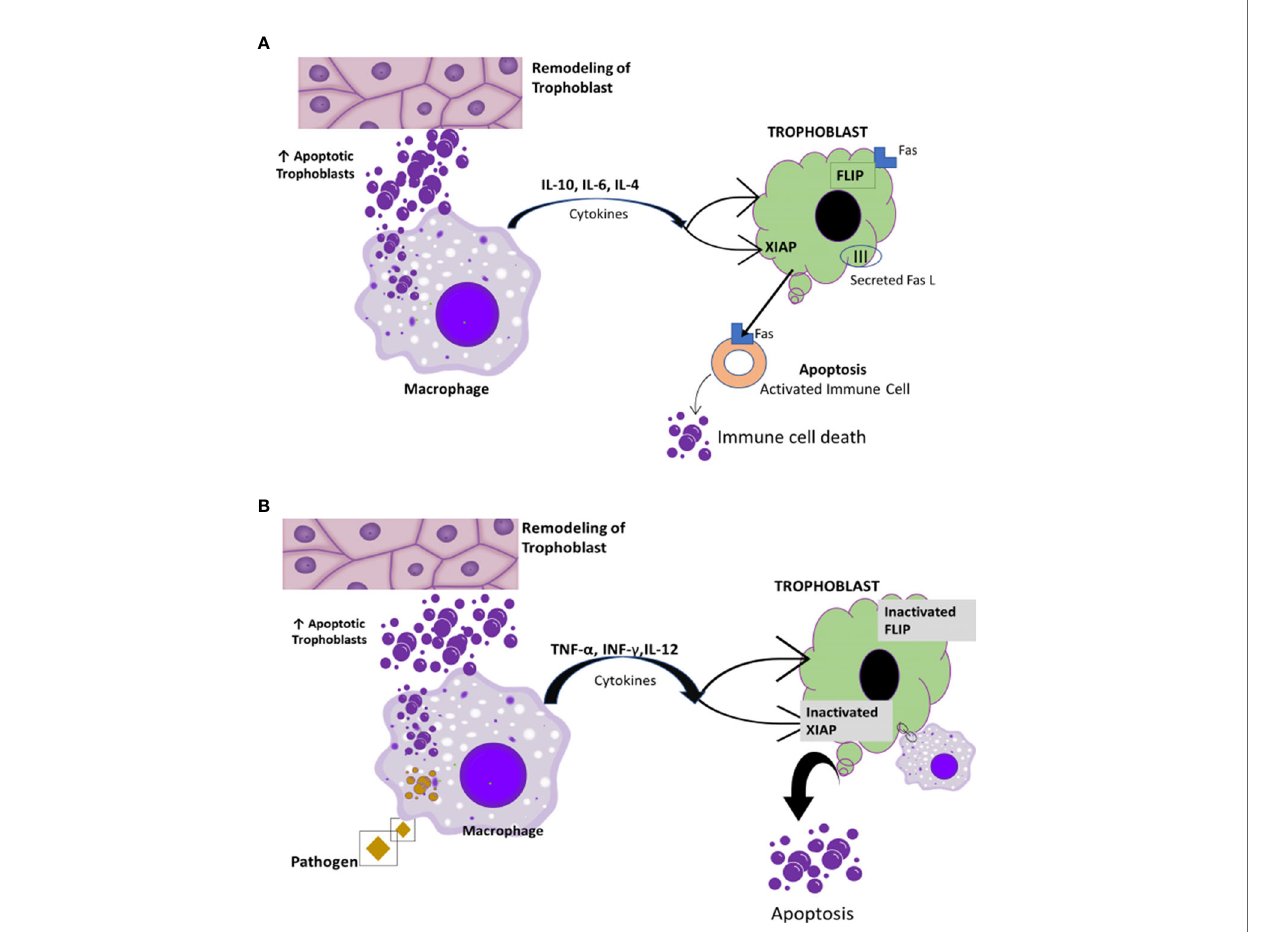
FIGURE 6 | Macrophage clearance effect of apoptotic cells. [Reproduced from (78)]. (A) Macrophages engulf apoptotic cells. This clearance induces the expression of anti-in fl ammatory cytokines such IL-4, IL-5, and IL-10 along with immunological tolerance and protection of trophoblast survival (78, 80). (B) Inef fi cient clearance and high level of apoptotic bodies induce pro-in fl ammatory cytokine predominance. This possibly results in trophoblast resistance to apoptosis mediated by Fas and the maternal immune system